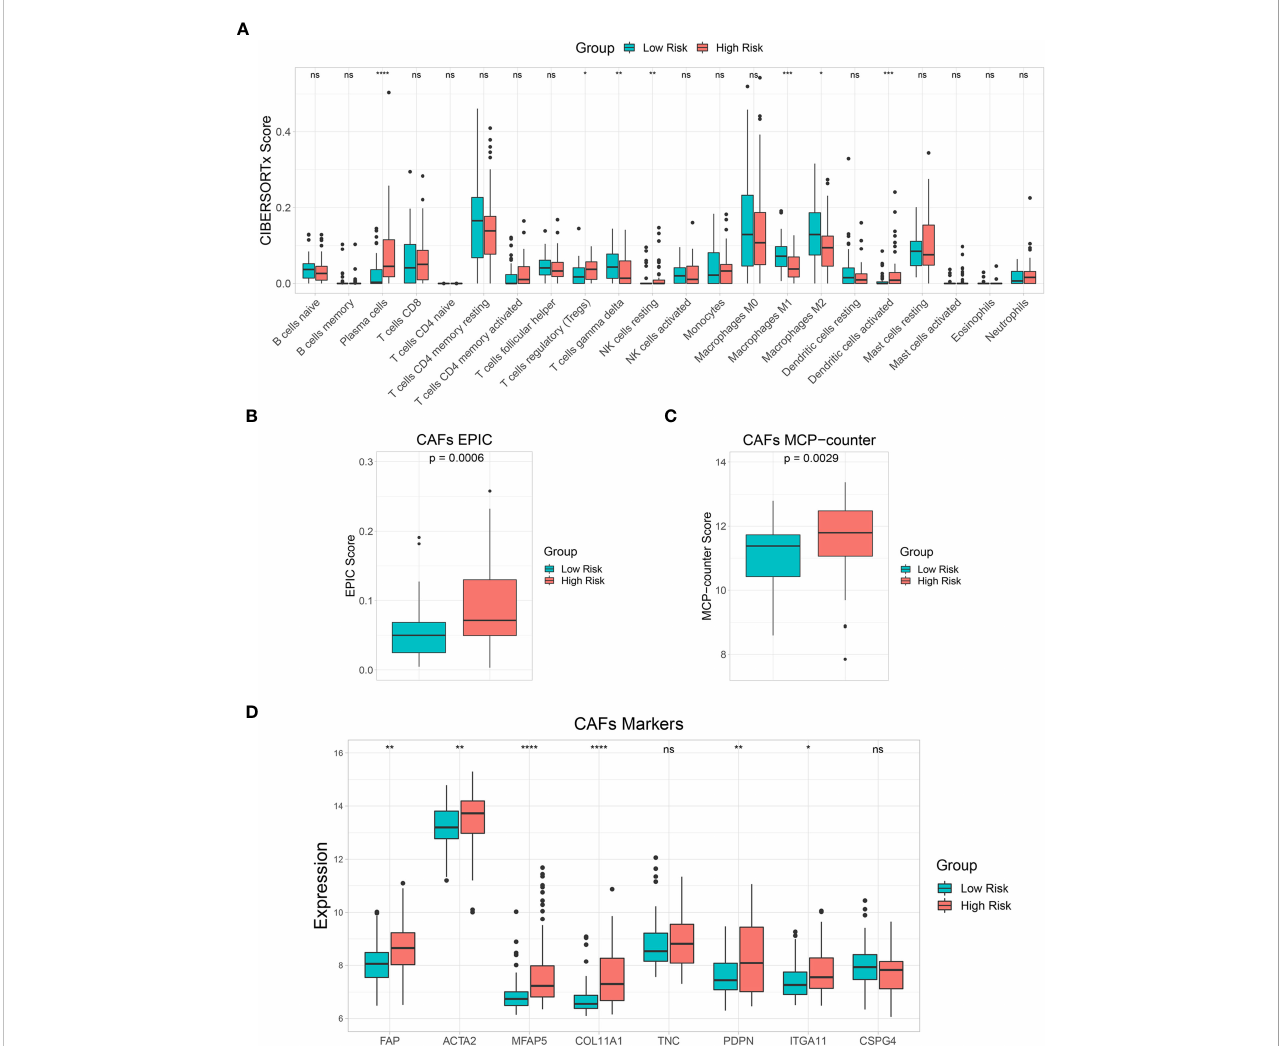
FIGURE 7 Immune cell in fi ltration and tumor microenvironment (TME) analysis. (A) A box plot showing the differences in multiple immune cells between low-risk and high-risk groups based on the CIBERSORTx algorithm. (B, C) A box plot showing differences in cancer-associated fi broblast (CAF) score based on EPIC and MCP-counter algorithms. (D) A box plot comparing CAF marker expression levels between risk groups. Key: ns, not signi fi cant; * p < 0.05; ** p < 0.01; *** p < 0.001; **** p <